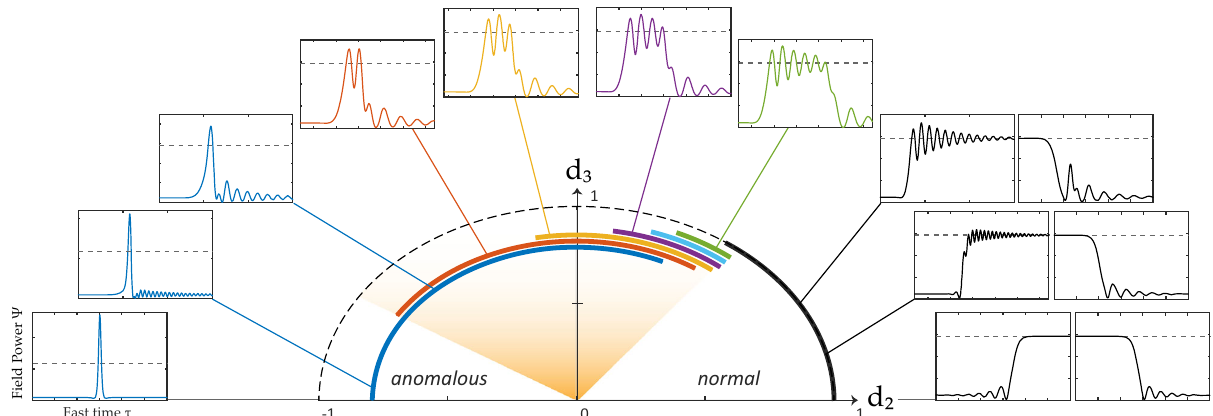
Fig. 1 | Localized dissipative structures in the second-/third-order dispersion ( d 2 = d 3 ) plane. Clockwise from left: conventional dissipative solitons, dissipative solitonswithdispersive-wavetails,zero-dispersionsolitonswithquantizedperiods (orange area), switching waves with dispersive-wave tails, conventional switching